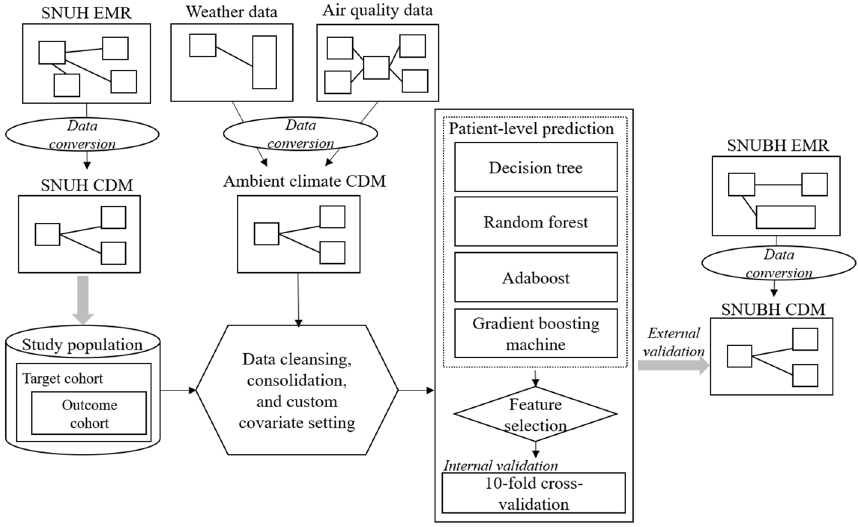
Figure 3. Overall methodology of the